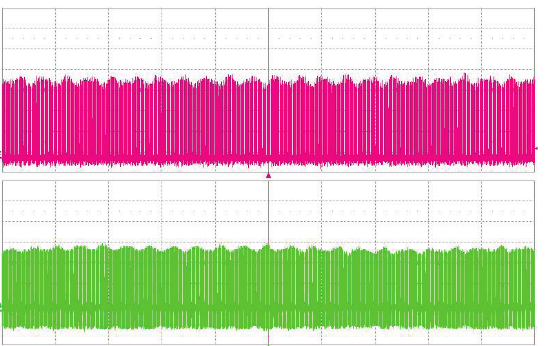
Figure 5. Oscillogram of dual-pulse regime. 1.06 µ m pump (upper trace), PPLN OPO radiation at 1.53 µ m (lower trace). Time scale is 500